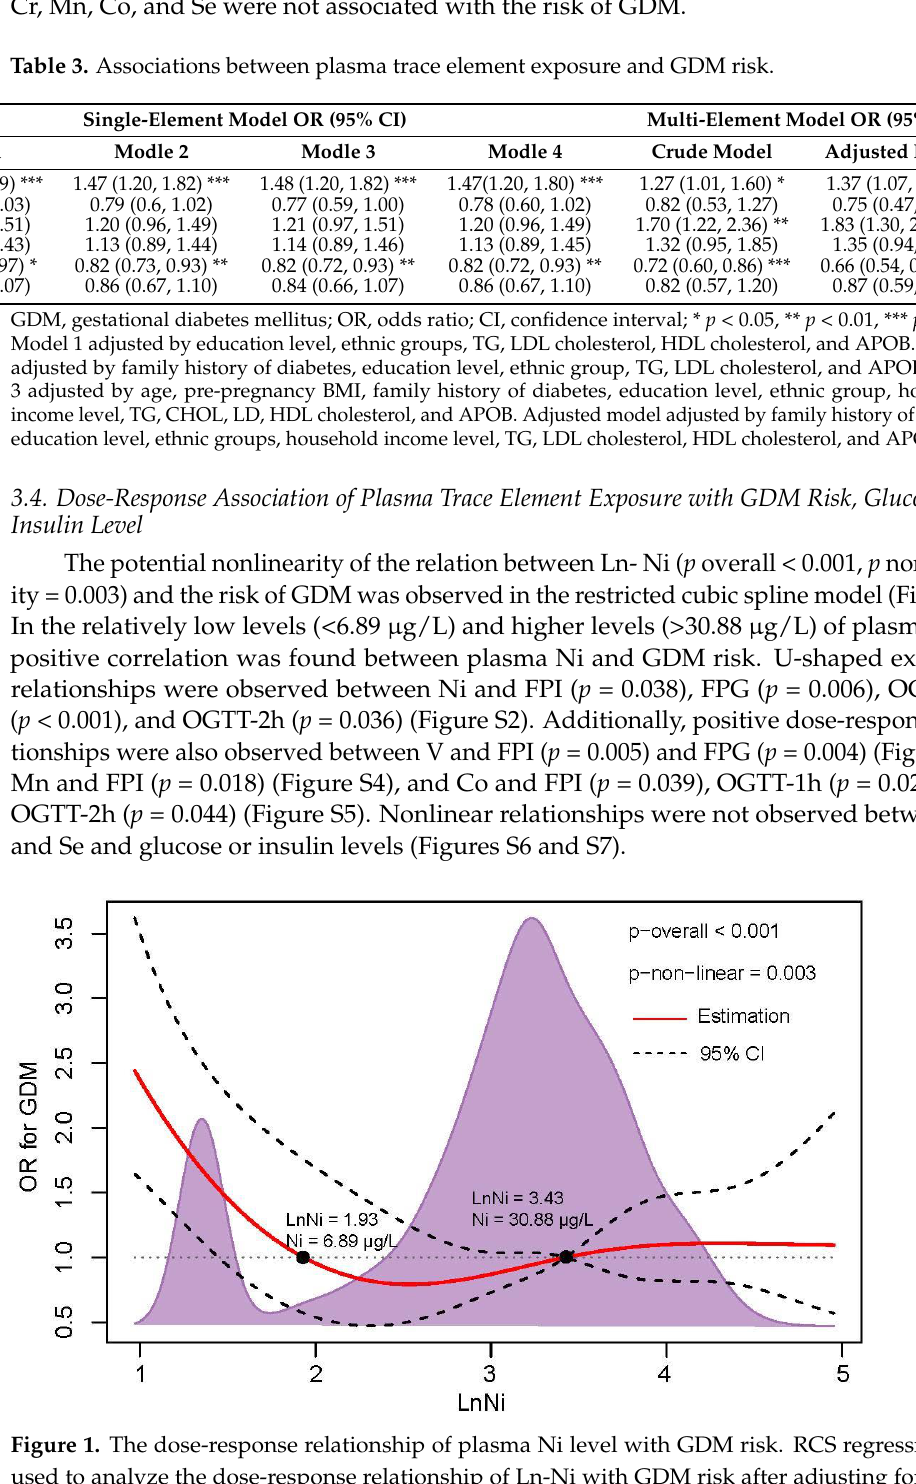
Figure 1. The dose‒response relationship of plasma Ni level with GDM risk. RCS regression was used to analyze the dose‒response relationship of Ln -Ni with GDM risk after adjusting for family history of diabetes, education level, ethnic groups, TG, LDL-cholesterol, and APO-B. The knots were located at the 25th, 50th, and 75th percentiles. The red line and black dotted line represent the OR value and 95% CI, respectively. The black points represent OR = 1, and the corresponding value of plasma Ni concentration is